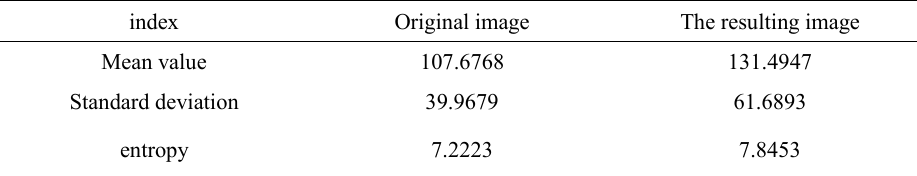
Table 1 Comparison of indicators of original image and processed image